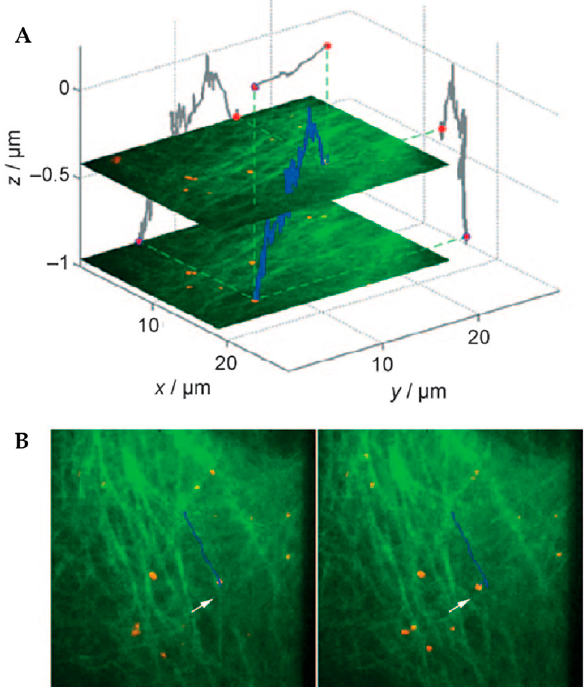
Figure 13. The addition of simultaneous widefield imaging to orbital tracking allowed trajectories (blue) of artificial viruses (red) to be placed in the environmental context of their interactions with the cytoskeleton as visualized with eGFP-labeled tubulin (green). ( A ) Trajectory of an artificial virus shown in 3D space with 2D projections across each axis shown in gray. ( B ) Two frames in a time series of images with trajectory overlaid. In the left frame, the particle is moving laterally not because the virus itself is changing microtubules, but because the microtubule itself was moving. This observation could not have been confirmed without simultaneously acquired imaging. Reprinted from reference